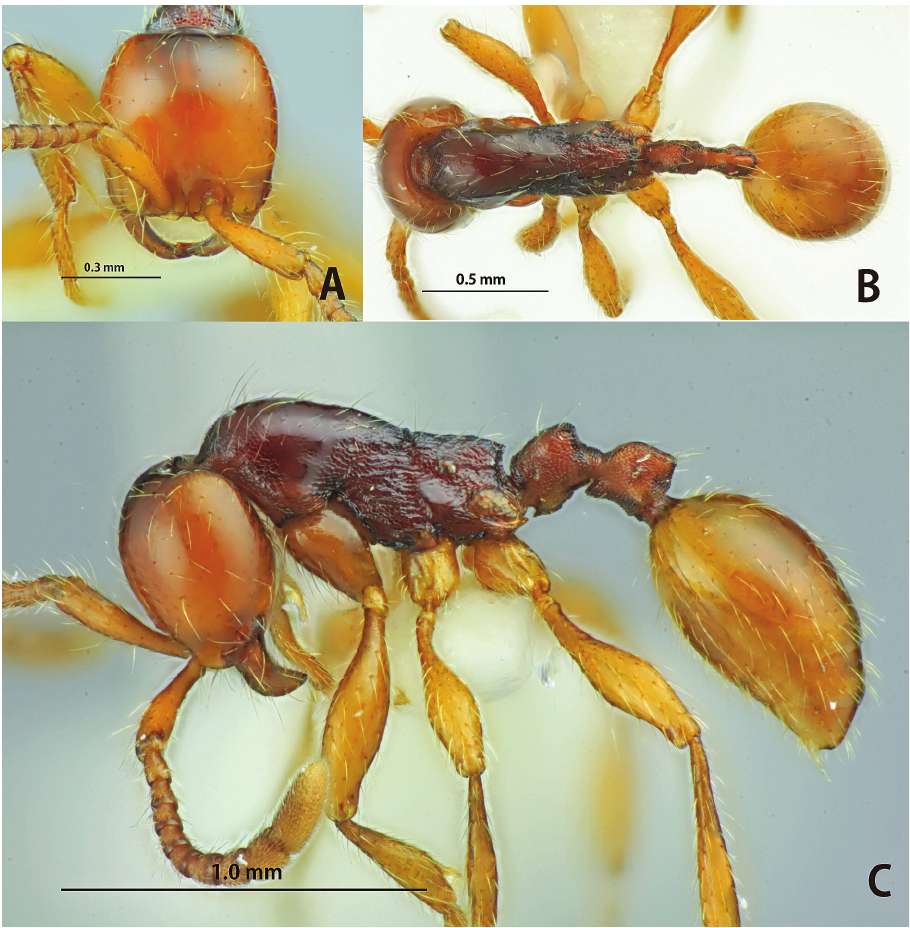
Figure 10. Aenictus khaoyaiensis (holotype). A Head in full-face view B body in dorsal view C body in feebly concave. Antennal scape relatively short, slightly extending beyond 1/2 of head length. Frontal carina relatively long, slightly extending beyond the level of posterior margin of torulus. Parafrontal ridge almost absent. Anterior clypeal margin feebly con- cave, concealed by curved anterior extension of frontal carina. Masticatory margin of mandible with 4 denticles, including a large apical tooth; basal margin feebly concave. Maximum width of gap between anterior clypeal margin and mandibles about 2.8 times as broad as maximum width of mandible. Promesonotum strongly convex dor- sally and sloping gradually to metanotal groove; mesopleuron demarcated from meta- pleuron by a shallow groove; metapleural gland bulla relatively large, its maximum diameter 2.3–2.8 times as long as distance between propodeal spiracle and metapleural gland bulla. Propodeum in profile extremely lower than pronotum and relatively short with feebly convex dorsal outline; propodeal junction angulate, overhanging the de-